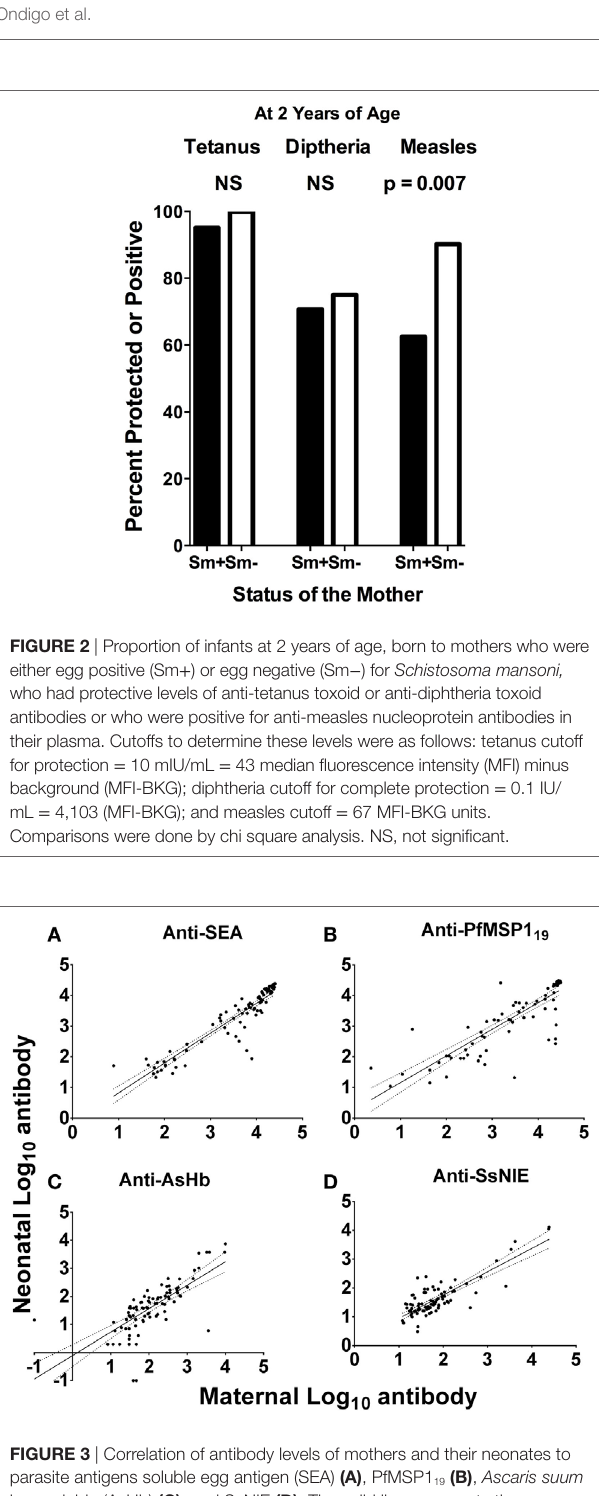
followed by a positive response (5 children); and (D) two to four positive responses in consecutive bleed periods (33